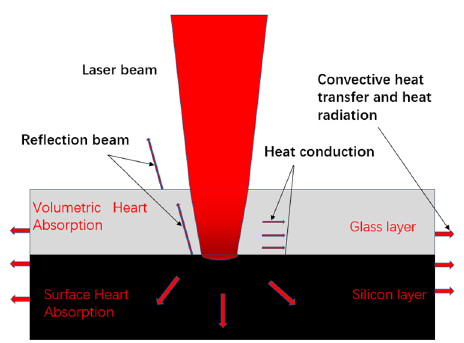
Figure 2. Schematic of the laser irradiates the glass-silicon double layer wafer.